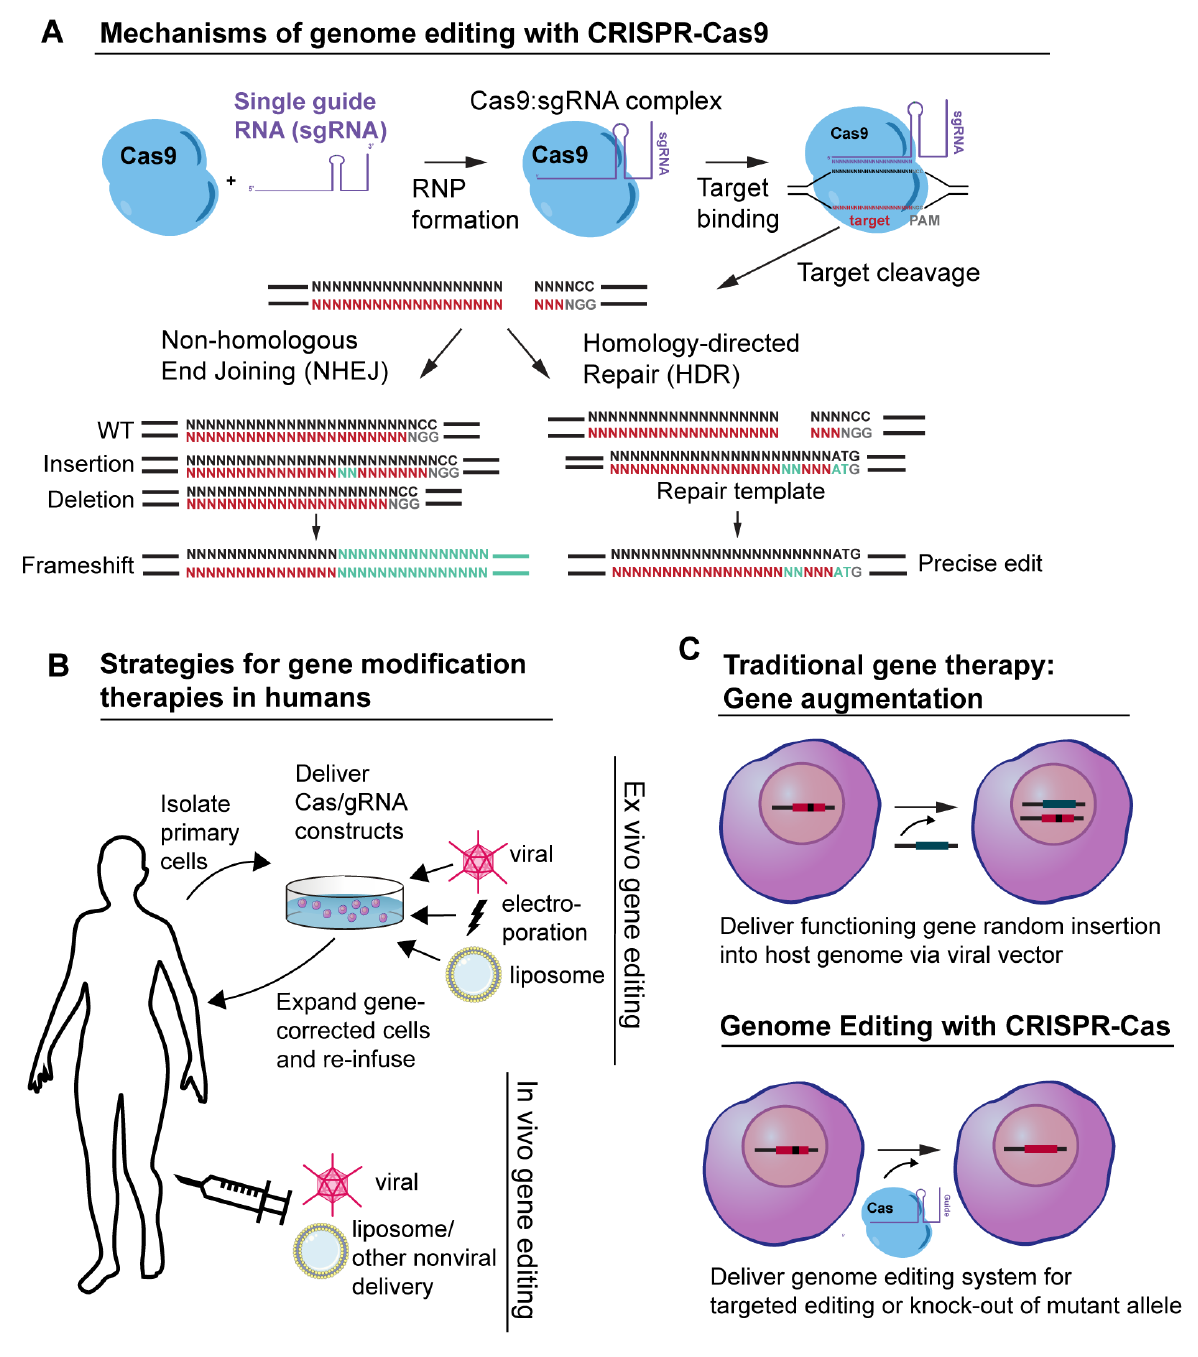
Figure 1. CRISPR-Cas9 gene editing strategies. ( A ) Mechanism of CRISPR-Cas9 genome editing. Cas9 nuclease complexes with a single guide RNA (sgRNA) to form a ribonucleoprotein (RNP). The sgRNA guides Cas9 to create a double strand break (DSB) three to four base pairs proximal to an “NGG” PAM sequence. After creating a DSB, dsDNA can be repaired by either non-homologous end joining (NHEJ) or, when a homologous dsDNA donor template is available, homology-directed repair (HDR). ( B ) Strategies for gene modification therapies in humans. Ex vivo gene editing strategies involve the extraction and manipulation of patient-derived cells in vitro in cell culture. Gene-corrected cells are expanded in culture and are subsequently re-infused or grafted onto the patient. In vivo gene editing involves the direct delivery of CRISPR- Cas DNA, RNA, and/or protein via viral or nonviral means. ( C ) Traditional gene therapy versus genome editing with CRISPR-Cas technology. Traditional gene therapy involves the addition of a functioning gene to replace a mutant allele. The replacement gene is usually inserted randomly into the host genome via a viral vector. In contrast, genome editing with CRISPR-Cas involves the direct, site-specific editing of the host